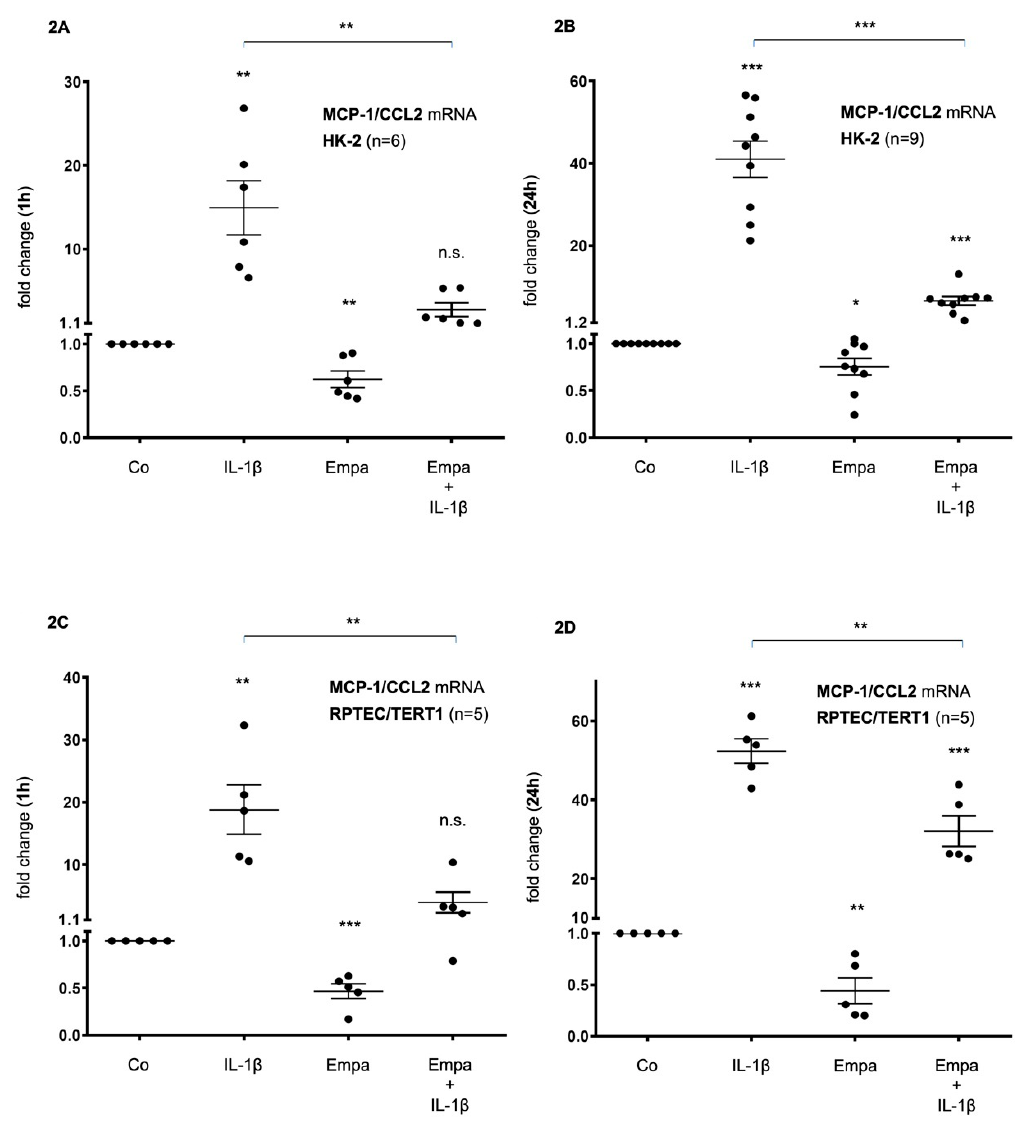
Figure 2. Inhibitory effect of empagliflozin on basal and IL-1 β -induced MCP-1/CCL2 mRNA expression in human proximal tubular cells (HPTC). HPTCs were serum- and supplement-starved for 24 h and then stimulated for 1 h ( A , C ) or 24 h ( B , D ) with IL-1 β (10 ng/mL), 500 nM empagliflozin (Empa), or a combination of Empa (500 nM) and IL-1 β (10 ng/mL). Controls (Co) were left unstimulated for 1 h ( A , C ) or 24 h ( B , D ). Data are presented as fold induction above MCP-1/CCL2 control levels after normalizing to GAPDH expression. For each experimental condition, data of (n) independent experiments are presented as dots in scatter plot graphs with the respective mean ± SEM bars. ( A , B ) In HK-2 cells, IL-1 β (10 ng/mL) led to a 15-fold and 41-fold induction of MCP-1/CCL2 mRNA expression after 1 h ( A ) and 24 h ( B ) of ligand stimulation, respectively (** p < 0.01 and *** p < 0.001, respectively, when compared with unstimulated control cells). Empa (500 nM) downregulated basal MCP-1/CCL2 mRNA expression by 0.6-fold and 0.8-fold after 1 h ( A ) and 24 h ( B ), respectively (** p < 0.01 and * p < 0.05, respectively, when compared with unstimulated control cells). Co-administration of Empa inhibited IL-1 β -mediated MCP-1/CCL2 mRNA expression after 1 h (0.2-fold, ** p < 0.01) ( A ) and 24 h (0.16-fold, *** p < 0.001) ( B ). cDNA from n = 6 ( A ) and n = 9 ( B ) independent RNA isolations was used for real-time PCR analysis, respectively. (C, D) In RPTEC/TERT1 cells, IL- 1 β (10 ng/mL) led to a 19-fold and 52-fold induction of MCP-1/CCL2 mRNA expression after 1 h ( C ) and 24 h ( D ) of ligand stimulation, respectively (** p < 0.01 and *** p < 0.001, respectively, when compared with unstimulated control cells). Empa (500 nM) downregulated basal MCP-1/CCL2